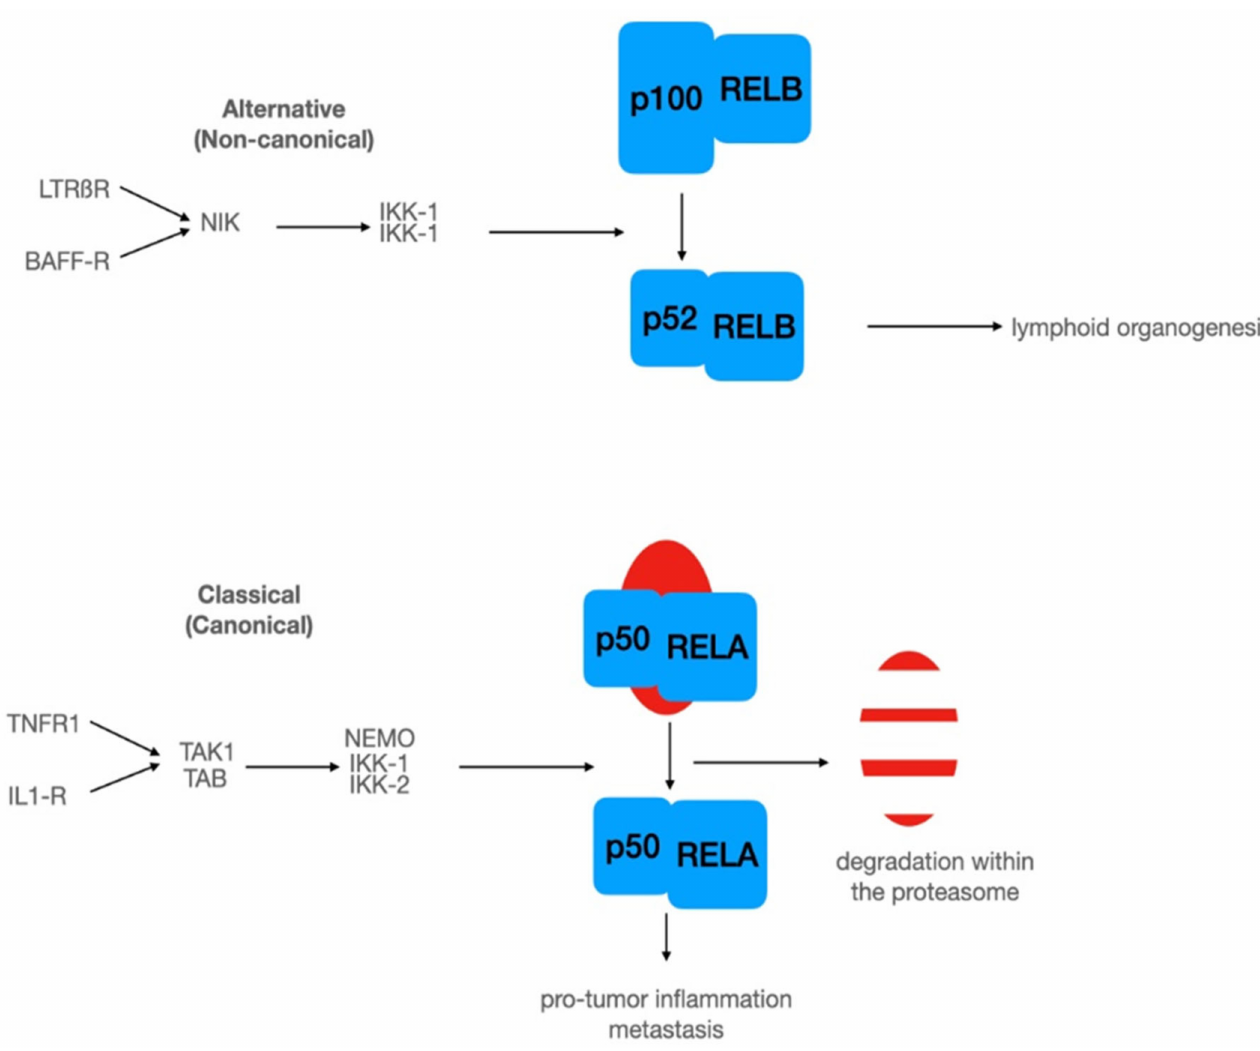
Figure 2. NF- κ B signaling involves at least two different pathways: An alternative pathway with upstream kinase NIK and a dimer of IKK-1. In this pathway, the precursor of p52 acts as an inhibitory subunit. The classical pathway involves a dimer of upstream kinases (TAK1, TAB), which could activate a trimeric signalosome composed of NEMO (docking component), IKK-1, and IKK-2. Activation of signalosome leads to phosphorylation of I κ B- α at serine 32 and 36, followed by ubiquitination and subsequent degradation within the proteasome. For further details, see the